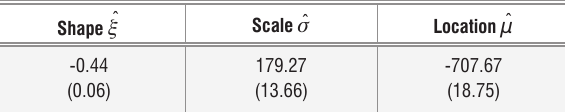
Maximum likelihood estimates (standard errors) of the generalised extreme value distribution parameters